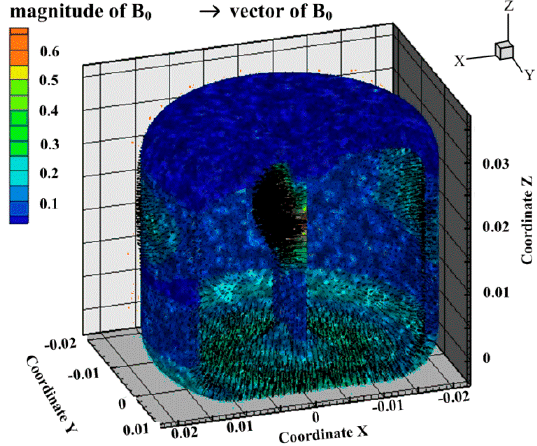
Figure 5. Contour and vector graph of the imposed magnetic field in the fluid channel.